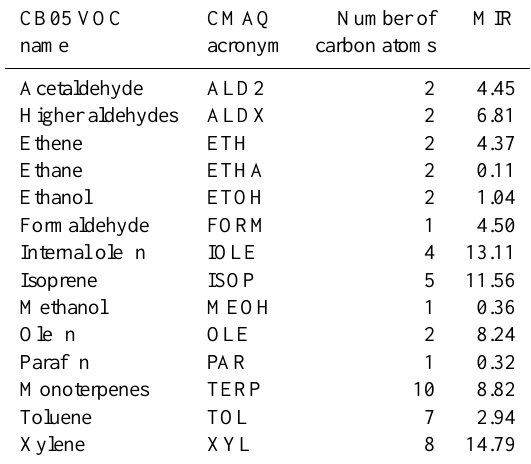
Table 1. Maximum incremental reactivity in CB05 VOC species on ozone production. CB05